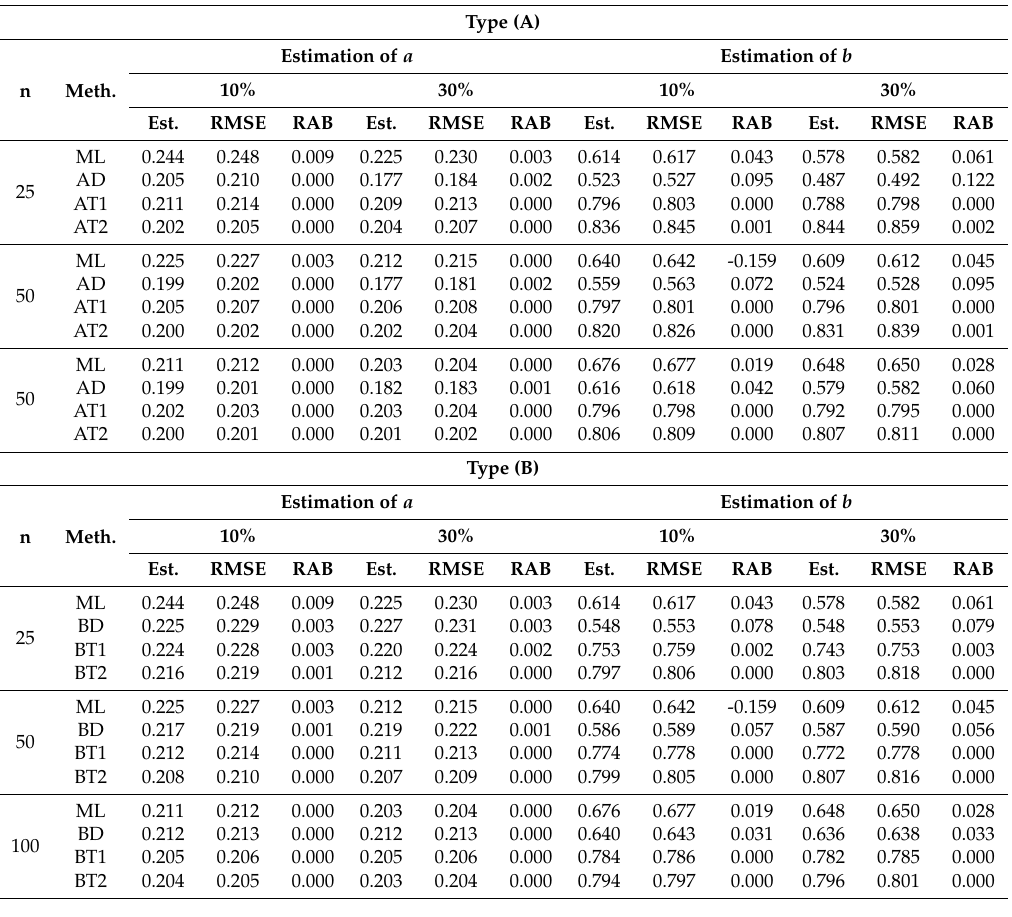
Table 3. The estimates, root of mean square error (RMSE) and relative absolute biases (RABs) for two parameters of the Weibull distribution using TL-moments, direct L-moments, and ML method based on left censoring ( a = 0.2 and b = 0.8) in the presence of